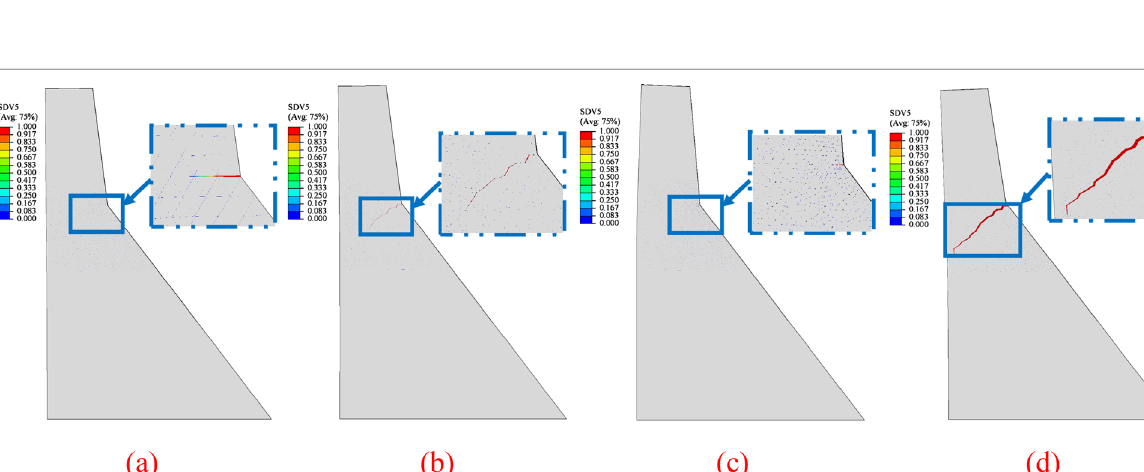
Fig. 28a and b shows the horizontal and vertical dis- placement responses of the node at the dams’ top with- out and with the longitudinal crack under earthquake, respectively. It can be seen that the time intervals of dis- placement peak points of the dam with the longitudinal crack are prolonged, which reflects that the longitudinal crack reduces the overall stiffness of the dam and leads to the advance of crack initiation time. The two vertical dis- placement time history curves are similar before 2 s (i.e., the time of crack initiation in the dam with the longitu- dinal crack); they are different but have the same trend after this time. Moreover, for the dam with the longitu- dinal crack, the time of the entire displacement time his- tory, i.e., the time of complete fracture, is less than that without the longitudinal crack.